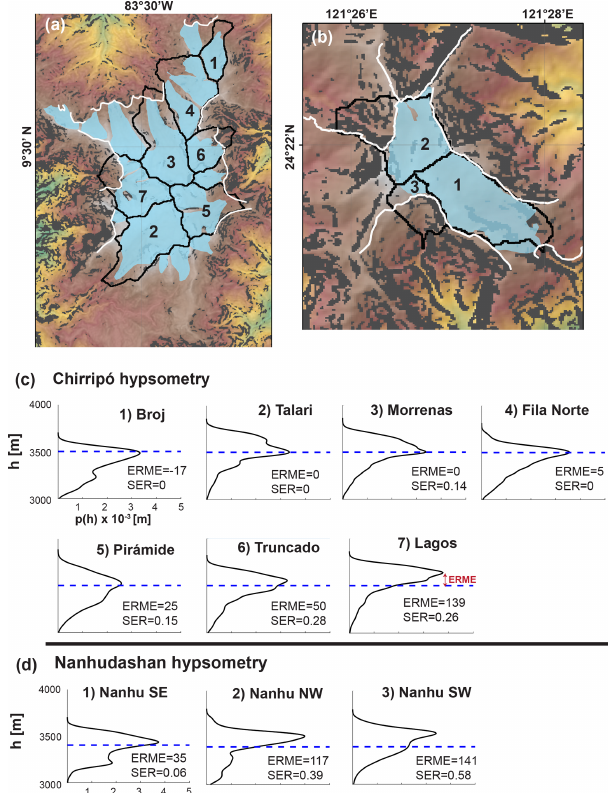
Figure 11. Glacial valley hypsometry at Chirripó and Nanhu- dashan. (a–b) DEM (green through red) of Cerro Chirripó and Nan- hudashan with LGM ice extent (blue) and postglacial scarp (white). Steep slopes ( > 30 ◦ ) in black. Numbered valleys correspond to black catchment outlines. (c–d) Hypsometry for catchments labeled in panels (a) – (b) .